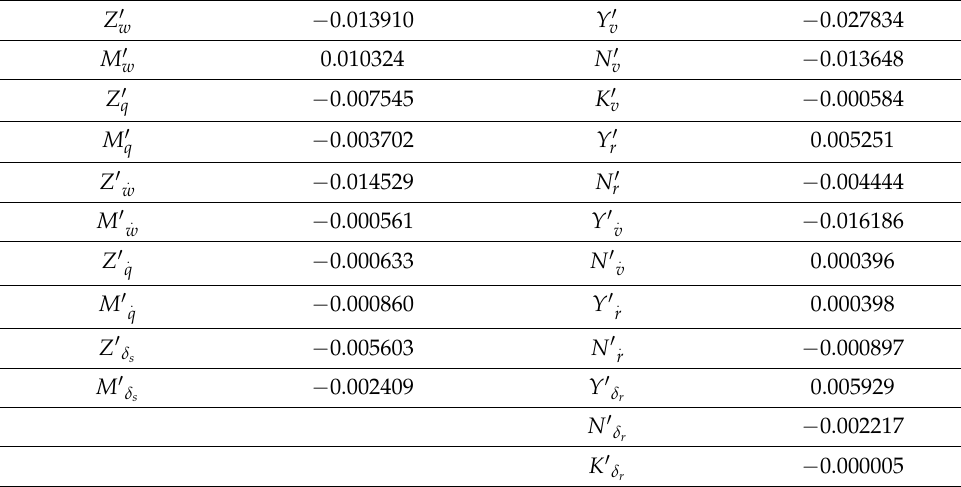
Table 3. Hydrodynamic coefficients of the DARPA SUBOFF